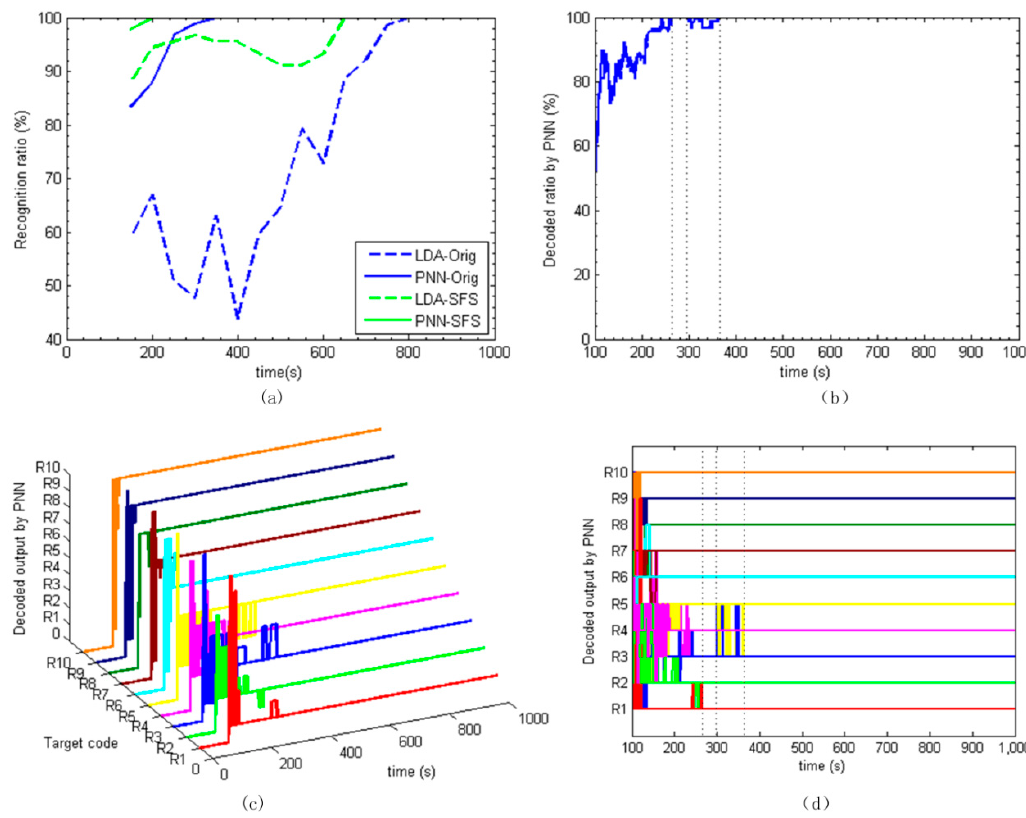
Figure 8. ( a ) LDA and PNN recognition performance using the extended dataset based on Orig and SFS feature set; ( b ) the real-time decoding ratio of PNN; ( c ) decoded trajectory plot of PNN; and ( d ) two-dimensional (2D) decoded output by PNN.